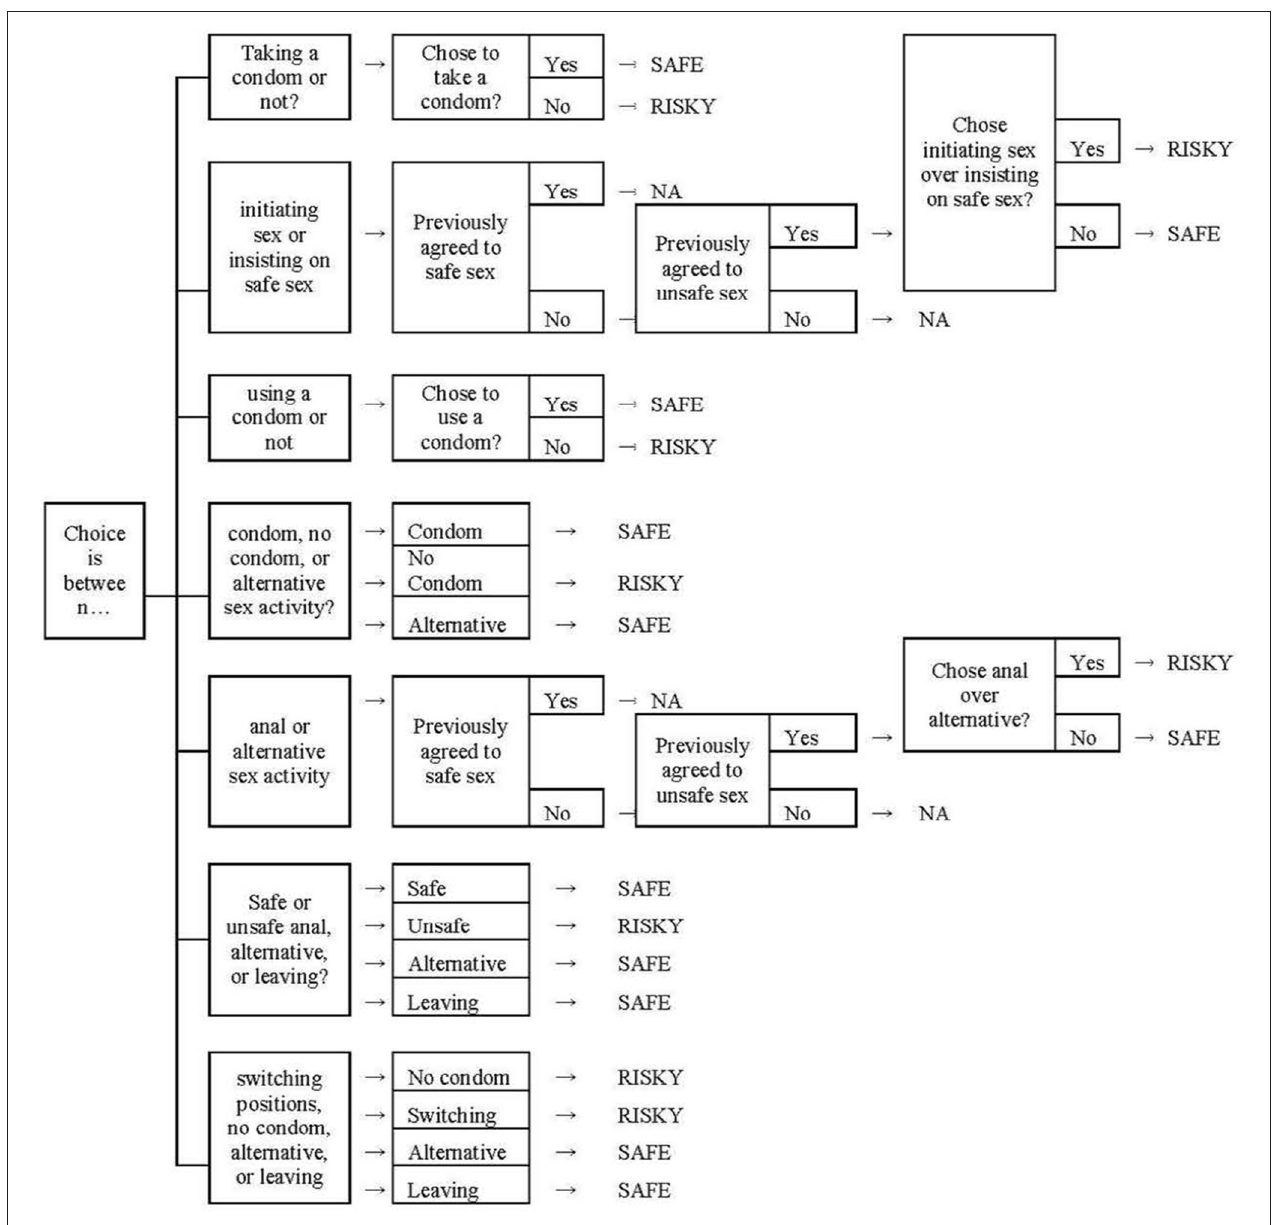
FIGURE 1 | Risk choice and safe sex procedures. This figure shows the procedures used to determine whether a sexually risky decision choice is safe or risky in the SOLVE game by taking into account the context of the choice. “NA” indicates a particular choice is not relevant to sexual risk-taking at all. This figure also appeared in the work by Smith et al. (2018). Authors are licensed to use this material, License number: 5047310486925. believable.” Participants rated game involvement items on a